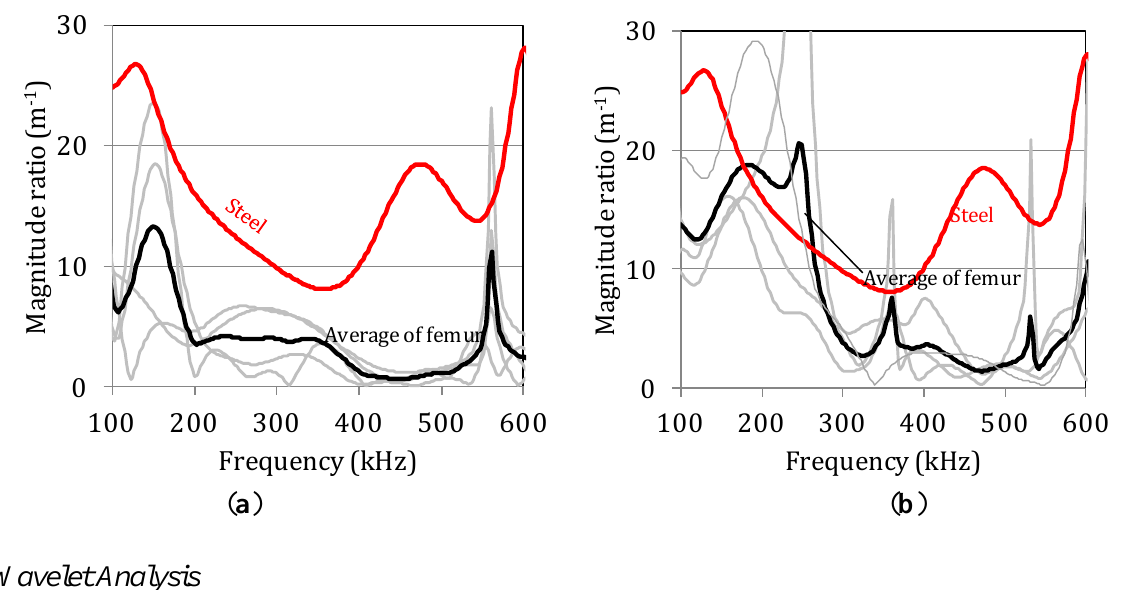
Figure 6. Magnitude decay vs . frequency curves derived from femur specimens with average thickness ( a ) 7.1 mm and ( b ) 5.8